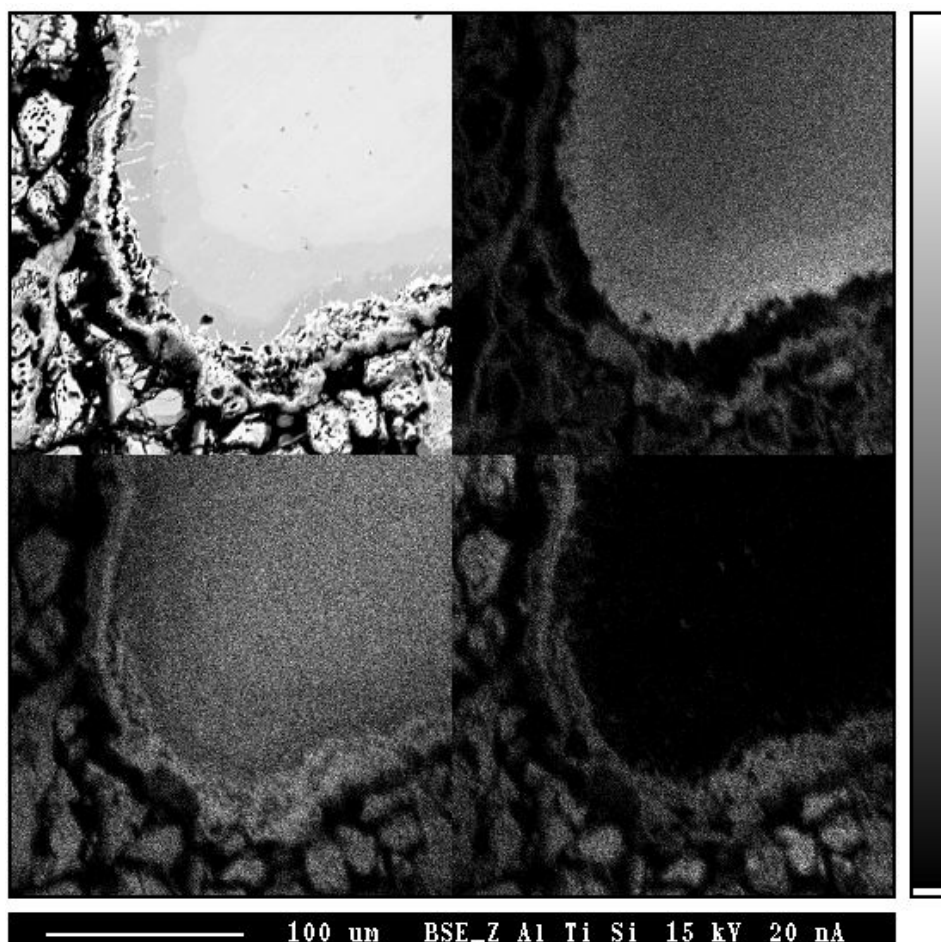
Figure 15. The BSE image (a) and X-ray maps (with respect to (b) Al, (c) Ti and (d) Si) of TiAl/TiSi powder mixture annealed at 1,100 °C for 40 h 2